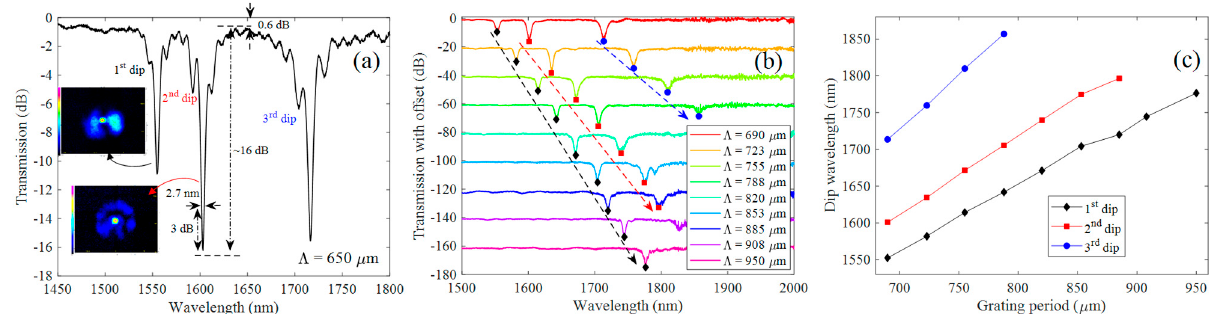
Figure 10. LPG transmission spectra acquired with the pressure induced method for a 3D printed amplitude mask with: ( a ) 690 µm period and ( b ) 690–950 µm periods. The insets shown in ( a ), are the experimental near-field profiles of the 1st and 2nd dip resonances. The screw displacement was set to induce the deepest mode losses. ( c ) Dip wavelength shift as function of the grating period for the different LPG resonances seen in ( b ).